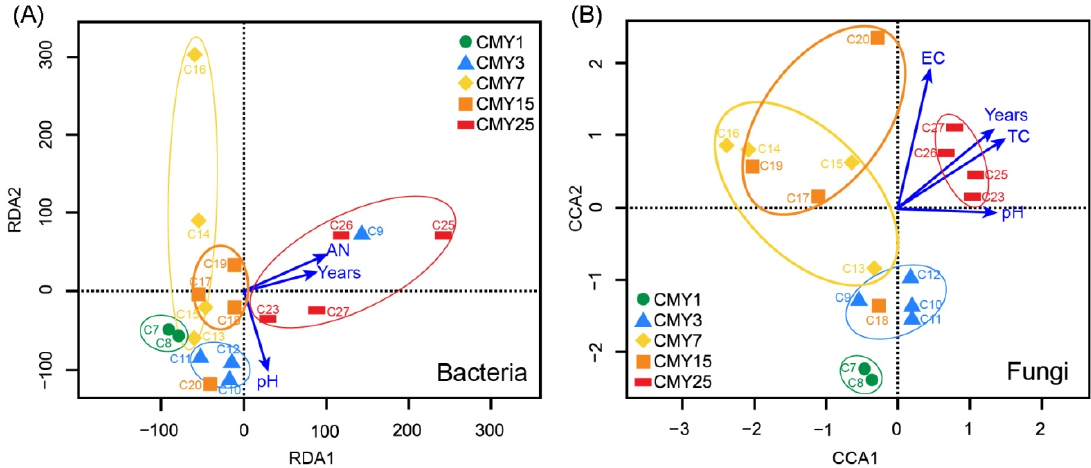
Figure 5. Redundancy analysis (RDA) of soil bacterial communities ( A ) and canonical correspondence analysis (CCA) of soil fungal communities ( B ) and soil properties under long-term cucumber monoculture systems. Lengths and angles of the arrows represent correlations between selected soil properties and soil communities, and the dots represent samples. AN: available nitrogen; EC: electronic conductivity; SOC: soil organic carbon; Years: years of